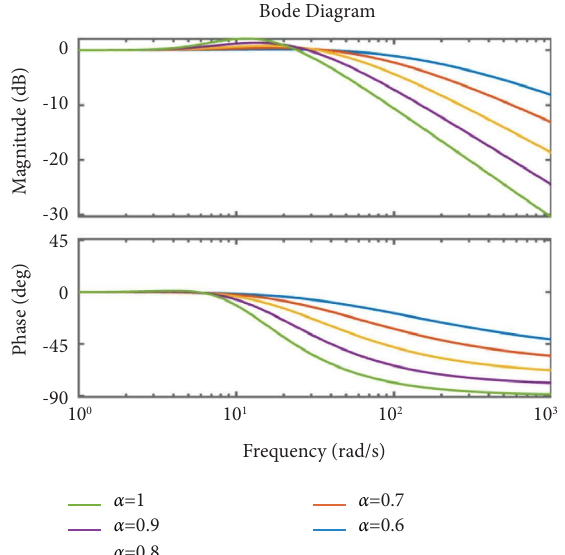
Figure 12: Te frequency-domain characteristic of FOESO input disturbance (observer order α